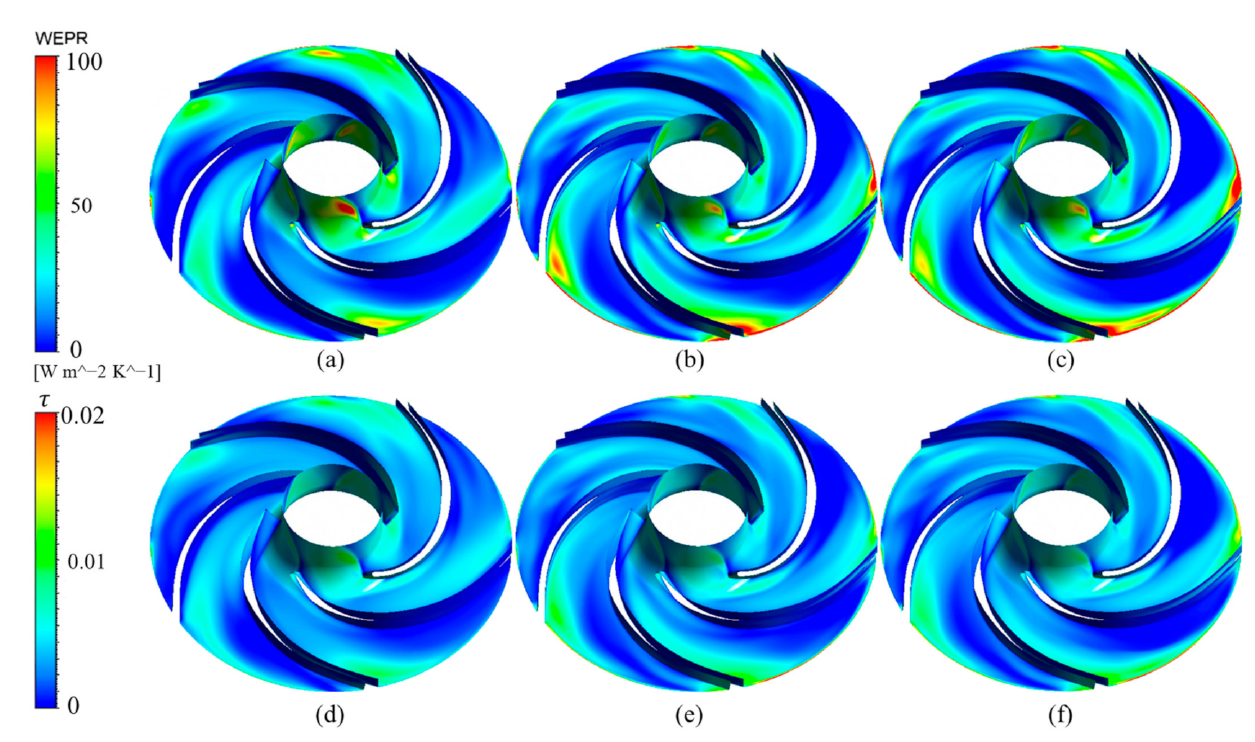
Figure 15. Comparative analysis of the WEPR and skin friction coefficient between impellers. ( a ) WEPR of impeller1, ( b ) WEPR of impeller3, ( c ) WEPR of impeller5, ( d ) τ ′ of impeller3, ( f ) τ of impeller5.